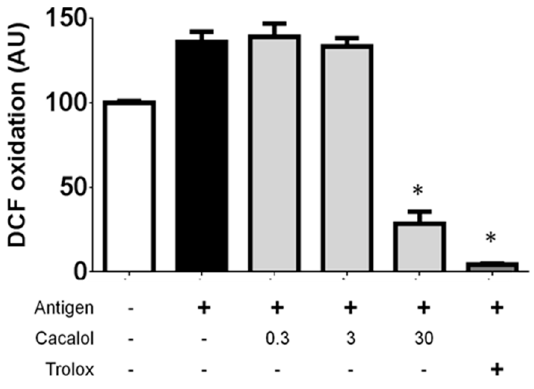
Figure 4. Cacalol inhibits Fc ε RI-triggered degranulation in BMMCs as the antioxidant Trolox does. * p ≤ 0.05.